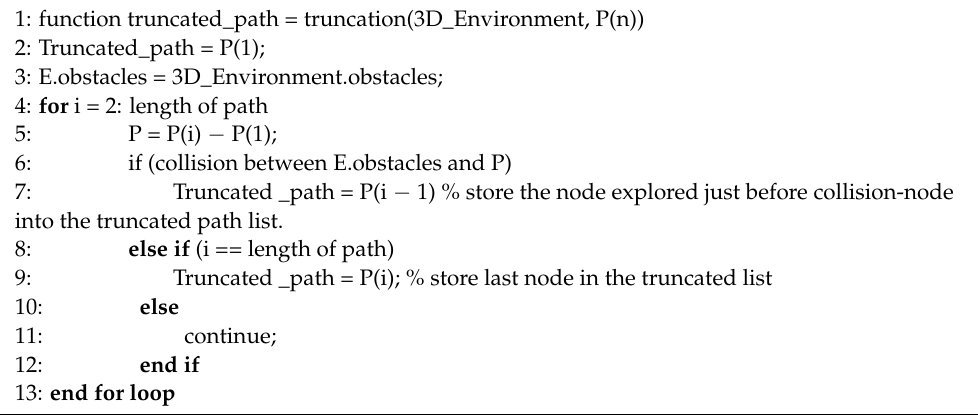
Algorithm 3 Proposed algorithm to refine the path obtained from conventional A*